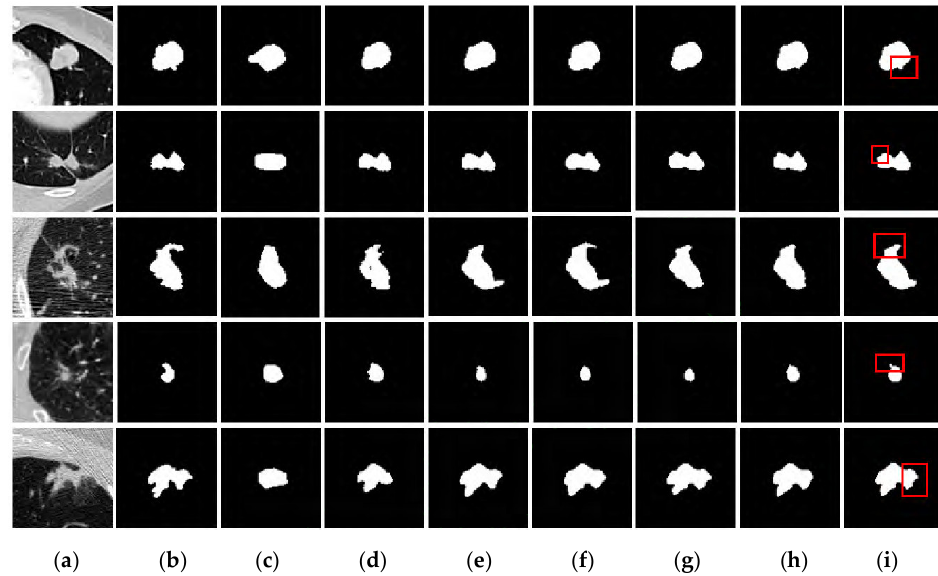
Figure 10. Comparisons of the visual effects of the experiment. ( a ) Original image; ( b ) gold Standard; ( c ) FCN; ( d ) SegNet; ( e ) U-Net; ( f ) Resnet; ( g ) U-net ++; ( h ) Densenet; and ( i ) MDRU-Net.